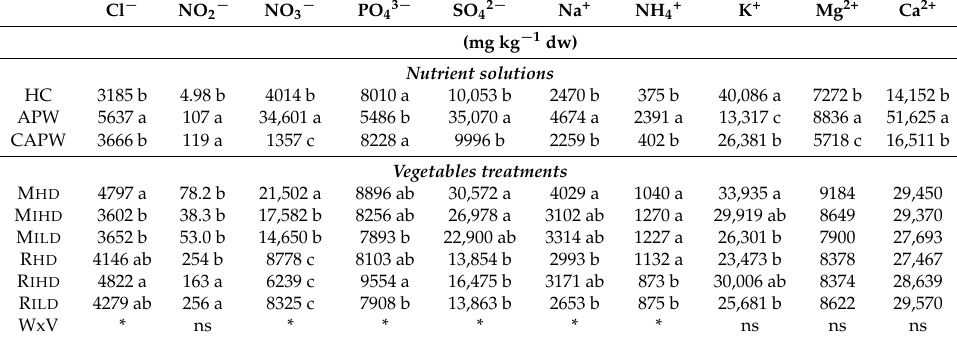
Table 6. Second growth cycle: Concentration of ions in the leaf biomass of rocket (R) and mizuna (M) when grown in different nutrient solutions (hydroponic, aquaponic water, complemented aquaponic water) and in different cultivation conditions (densities,